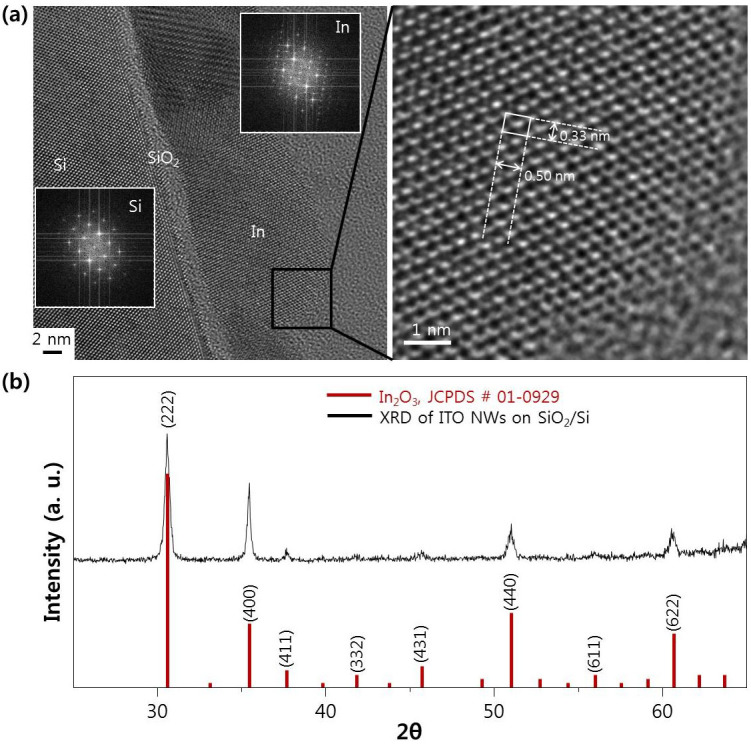
(a) HR-TEM image of metallic indium head at the early stage of growth. (b) XRD result of In(Sn) oxide nanowires grown on SiO2/Si(100) during 150 sec at 300°C (with JCPDS profile of In2O3).